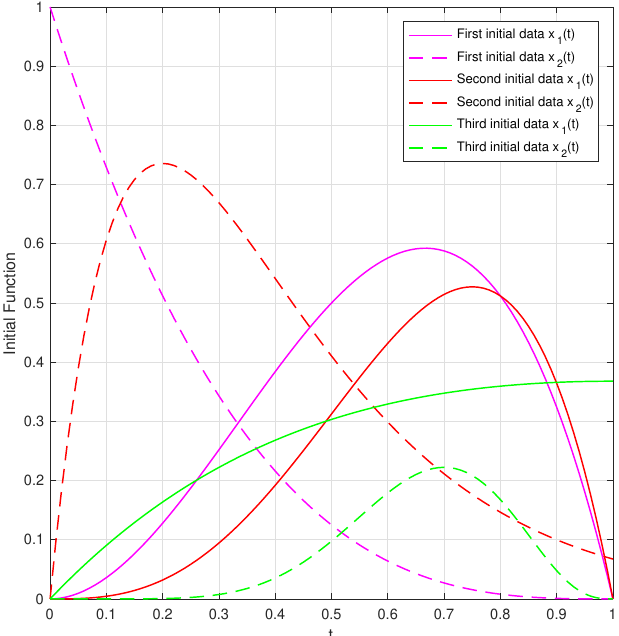
Figure 1. The initial functions x 1 and x 2 for each case in Example 1.